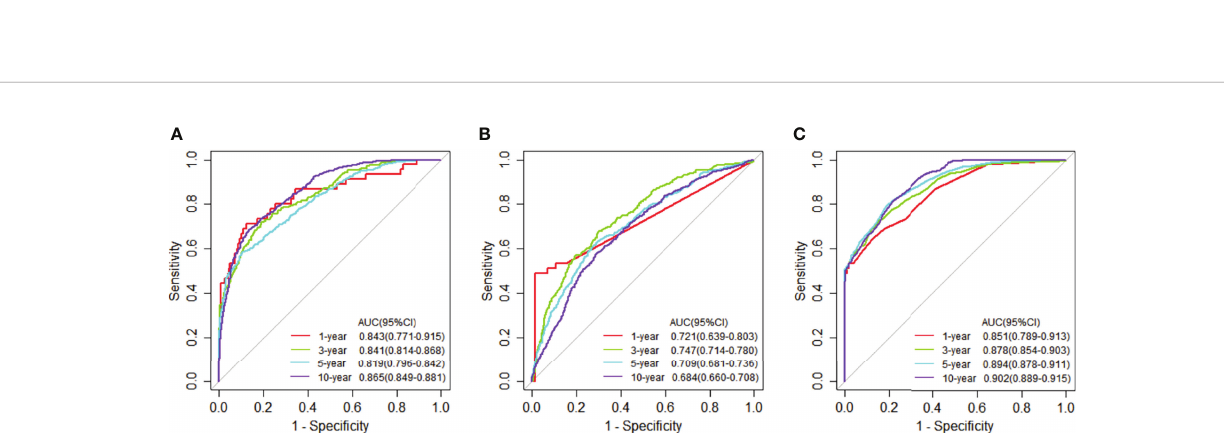
FIGURE 6 | Time-dependent receiver operating characteristic (ROC) curves for 1-, 3-, 5-, and 10-year mRNA expression data in METABRIC. (A) The ROC curves for JDINAC classi fi er. (B) The ROC curves for logistic regression classi fi er. (C) The ROC curves for random forest classi fi